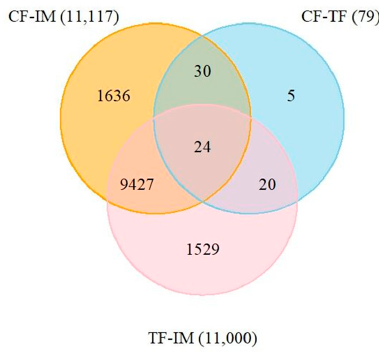
Figure 3. Analysis of DEGs by Venn diagram showing the number of DEGs in CF–TF, CF–IM, and TF–IM comparisons. All DEGs were determined on the basis of the statistical significance (false discovery rate (FDR) < 0.05). Table 1. Number of differentially expressed genes (DEGs).